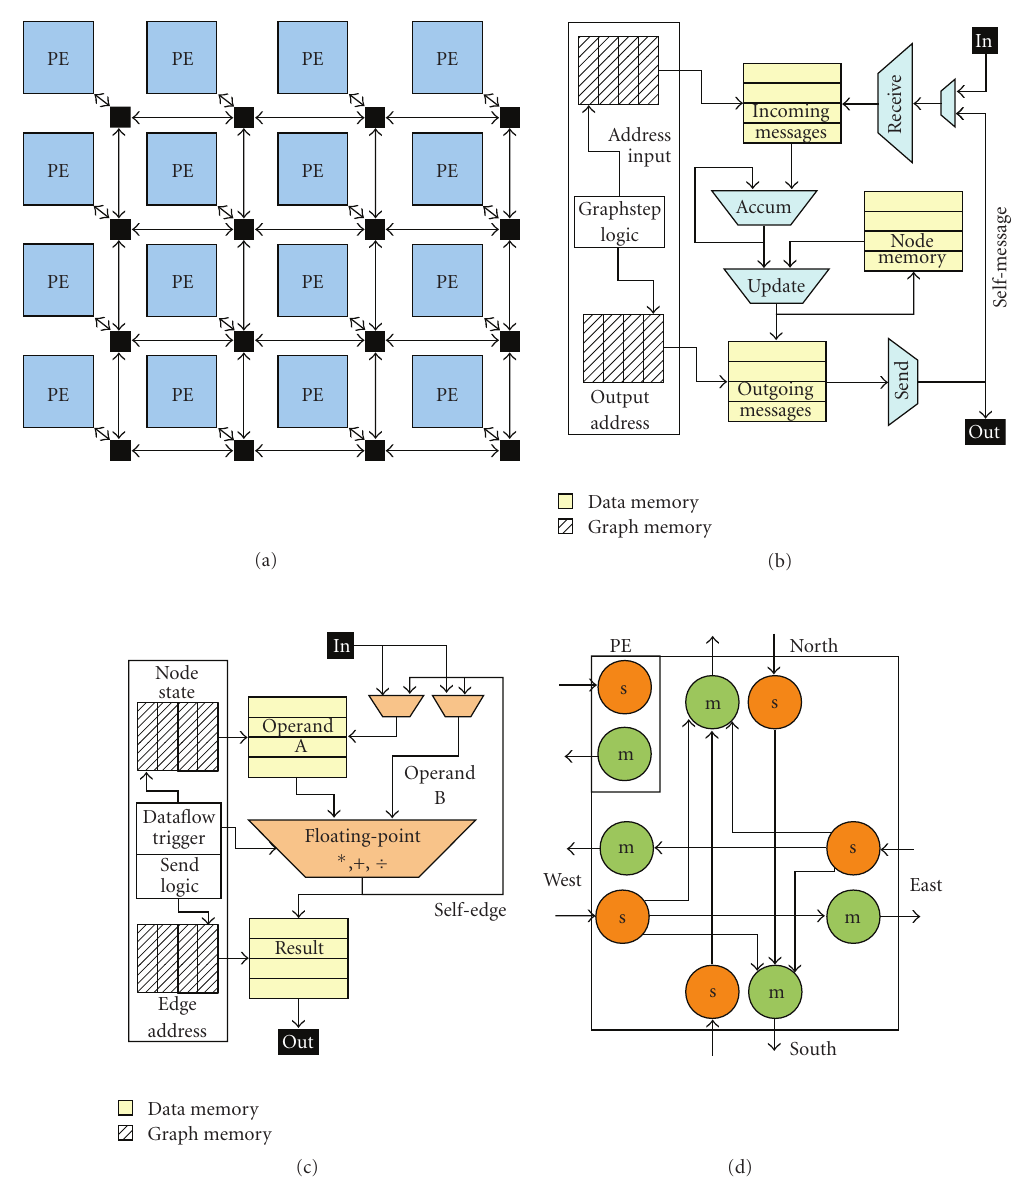
Figure 2: NoC architecture and